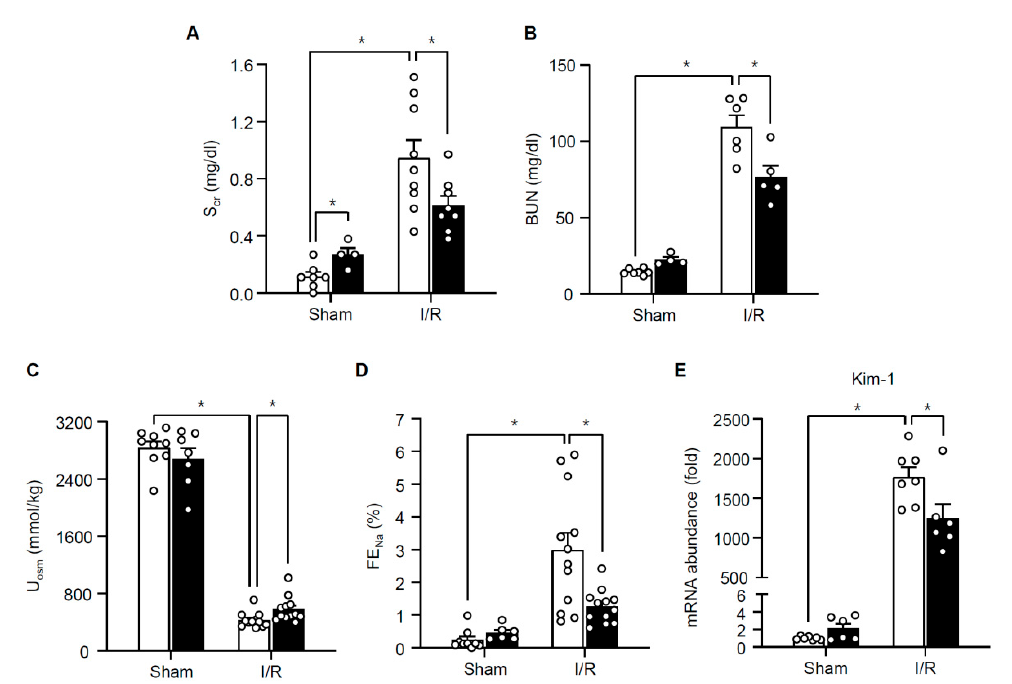
Figure 4. Serum creatinine (S cr , A ), blood urea nitrogen (BUN, B ), urine osmolality (U osm , C ), fractional excretion of sodium (FE Na , D ), and mRNA abundance for Kim-1 in renal cortices ( E ) from TonEBP +/ Δ (filled bars) mice and their TonEBP +/+ littermates (open bars) after I/R or sham treatment of kidneys. Mean + SEM, * p < 0.05.